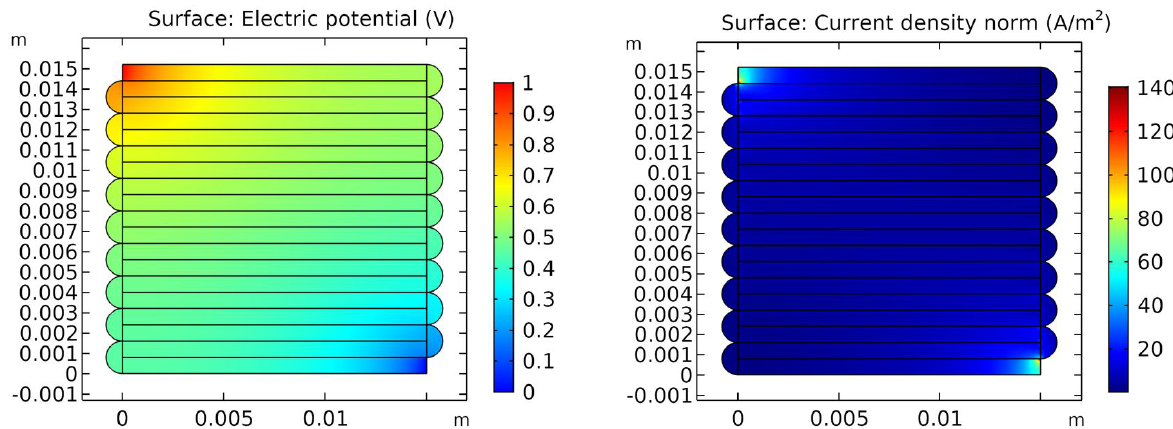
Figure 11. The FEM simulation results in COMSOL with the parameters from Table 2. The left figure presents the voltage distribution and the right one shows the current density